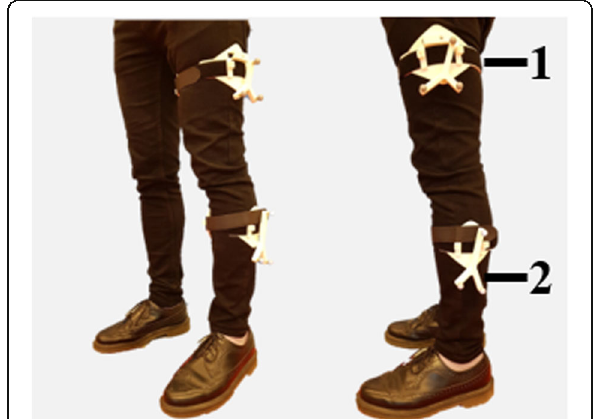
Fig. 2 Sample figure title. Figure legend